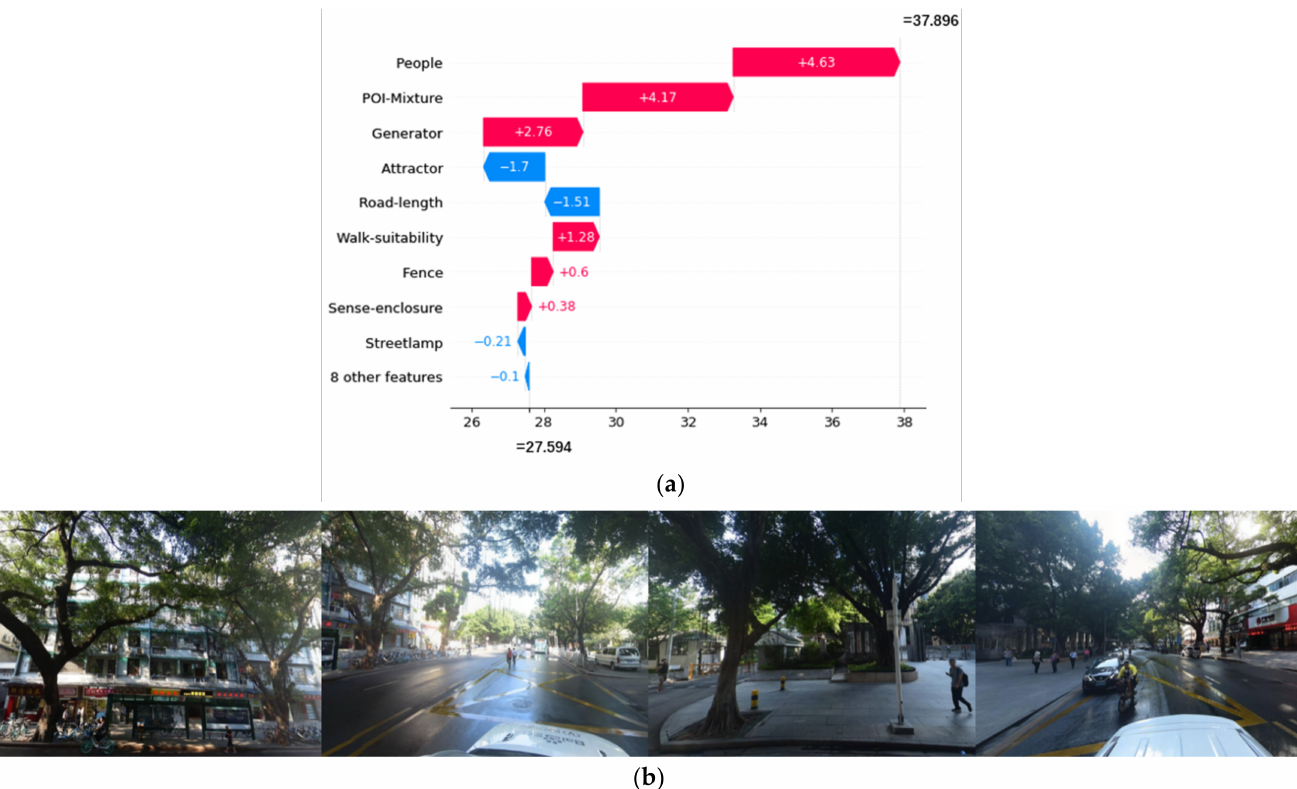
Figure 6. Local SHAP values of the features of the street segment with the highest frequency of street property crime. ( a ) Local SHAP values. ( b ) Examples of street-view